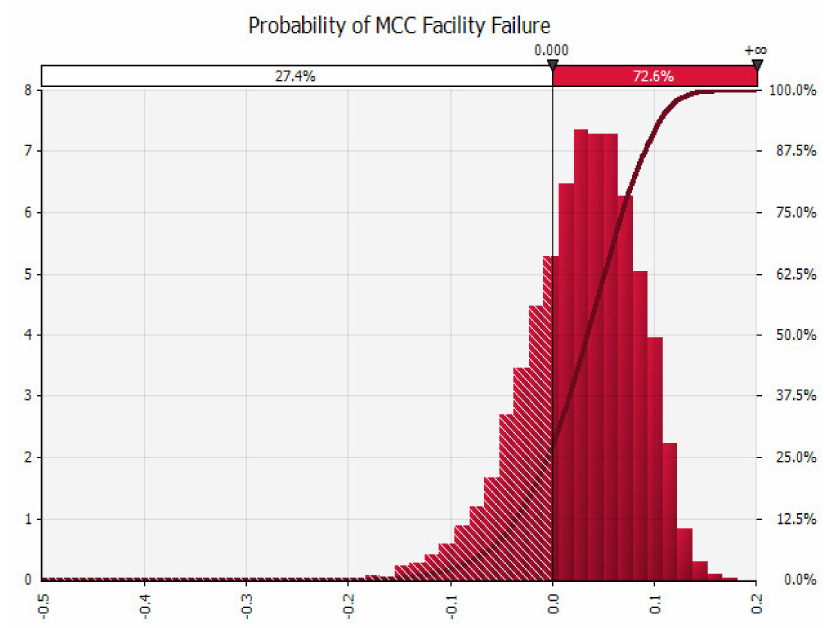
Figure 22. Probabilistic flood assessment result for NPP